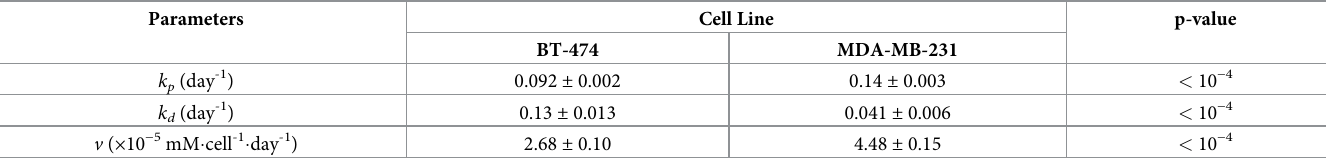
Table 3. Parameter estimates obtained from the global calibration procedure.